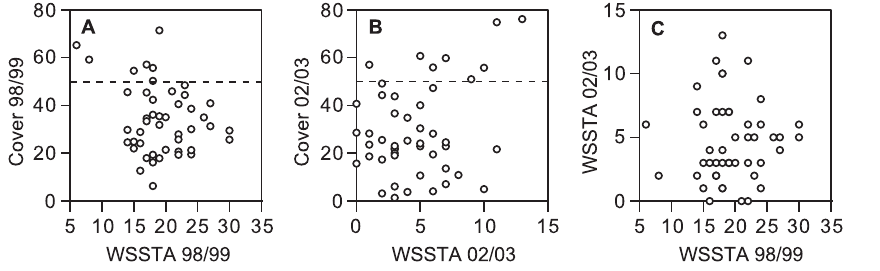
Figure 2. Relationship between Coral Cover and Thermal Stress (A and B) Relationships between thermal stress (number of WSSTAs) and total scleractinian coral cover during the two warmest summers of the study. Dashed line represents the empirical cover threshold of 50% that is generally required for high white syndrome frequency. (C) Relationship of thermal stress between the summers of 1998/1999 and 2002/2003 at 48 reefs on the GBR.